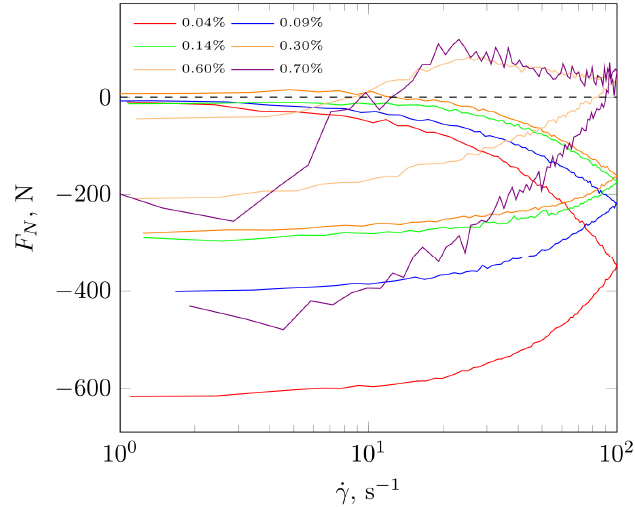
Figure 6. Changes in normal force value as a function of shear rate at increasing and decreasing values.